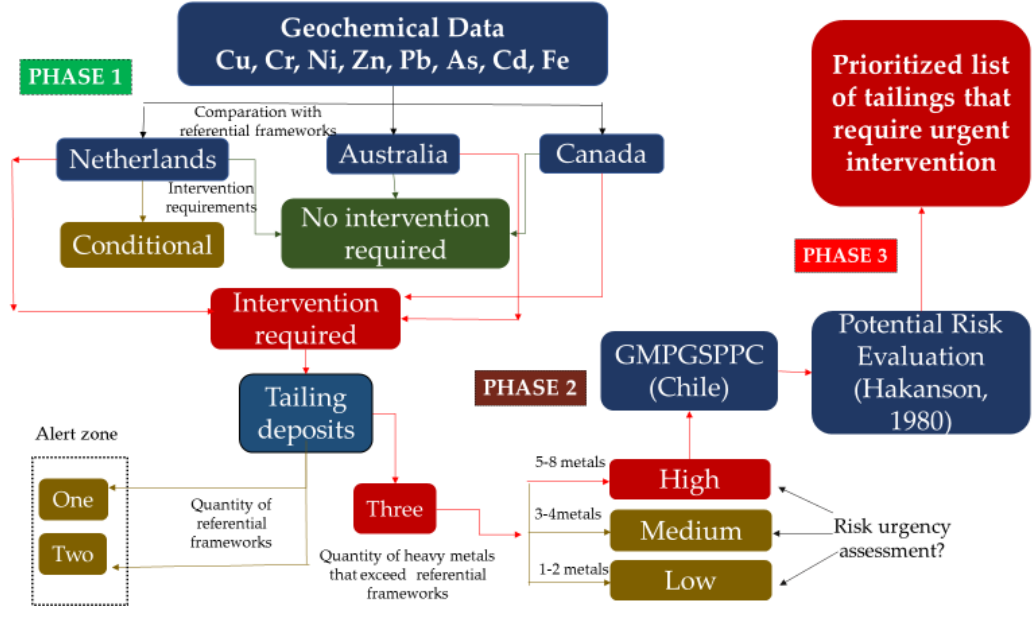
Figure 1. Description of the methodology.